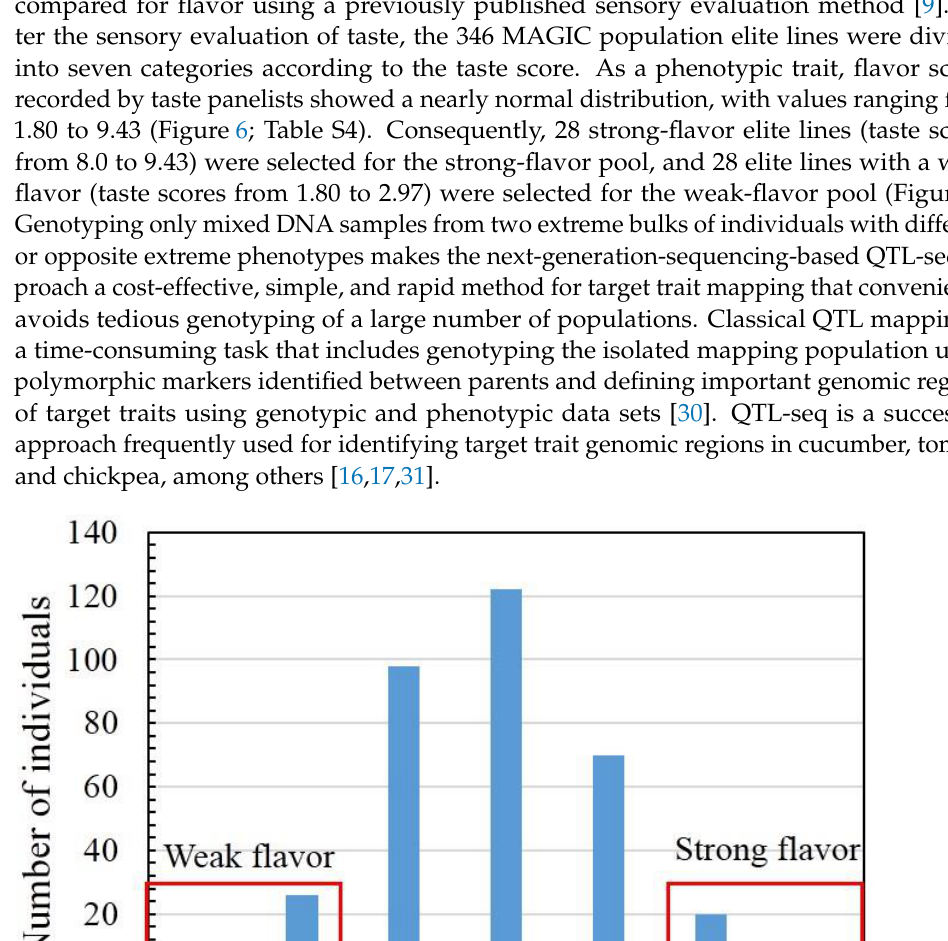
Table 1. Sequencing of parental lines and extreme bulks.